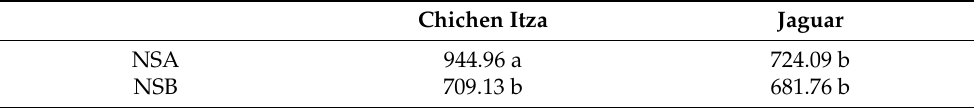
Table 6. Effect of the interaction between nutrient solutions (NSA and NSB; see Table 3) and habanero pepper cultivars (Chichen Itza hybrid and Jaguar variety) on yield per